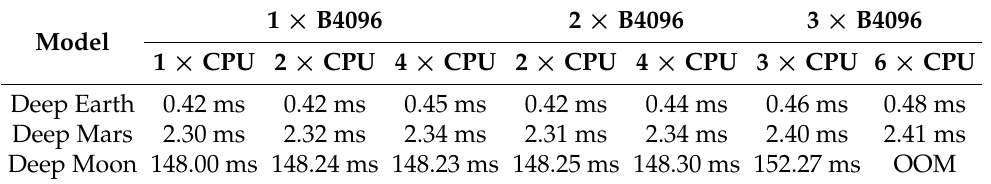
Table 14. Single-Stream benchmark results (90-percentile latency bound) for B4096 DPU